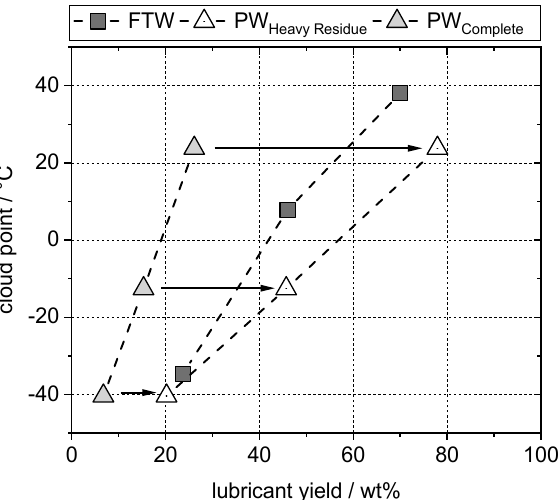
Figure 9. Cloud points of FT and PW lubricant over reaction temperatures at p = 100 bar, V ̇ wax = 0.42 mL/min.